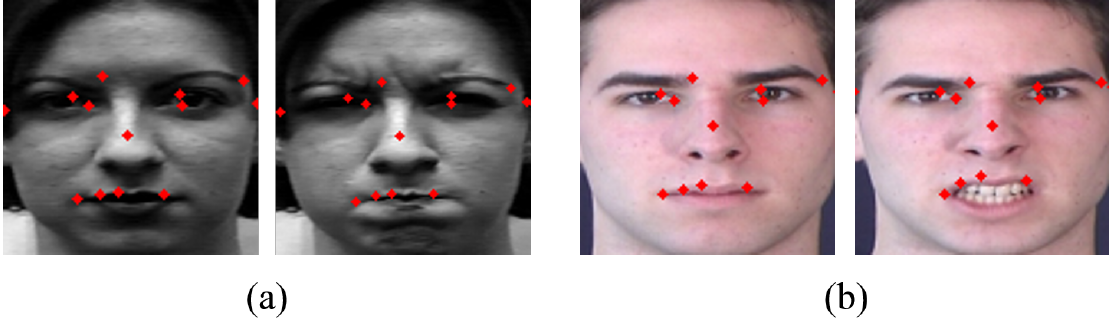
Figure 8. Top 13 landmarks: ( a ) CK+ dataset; and ( b ) MMI